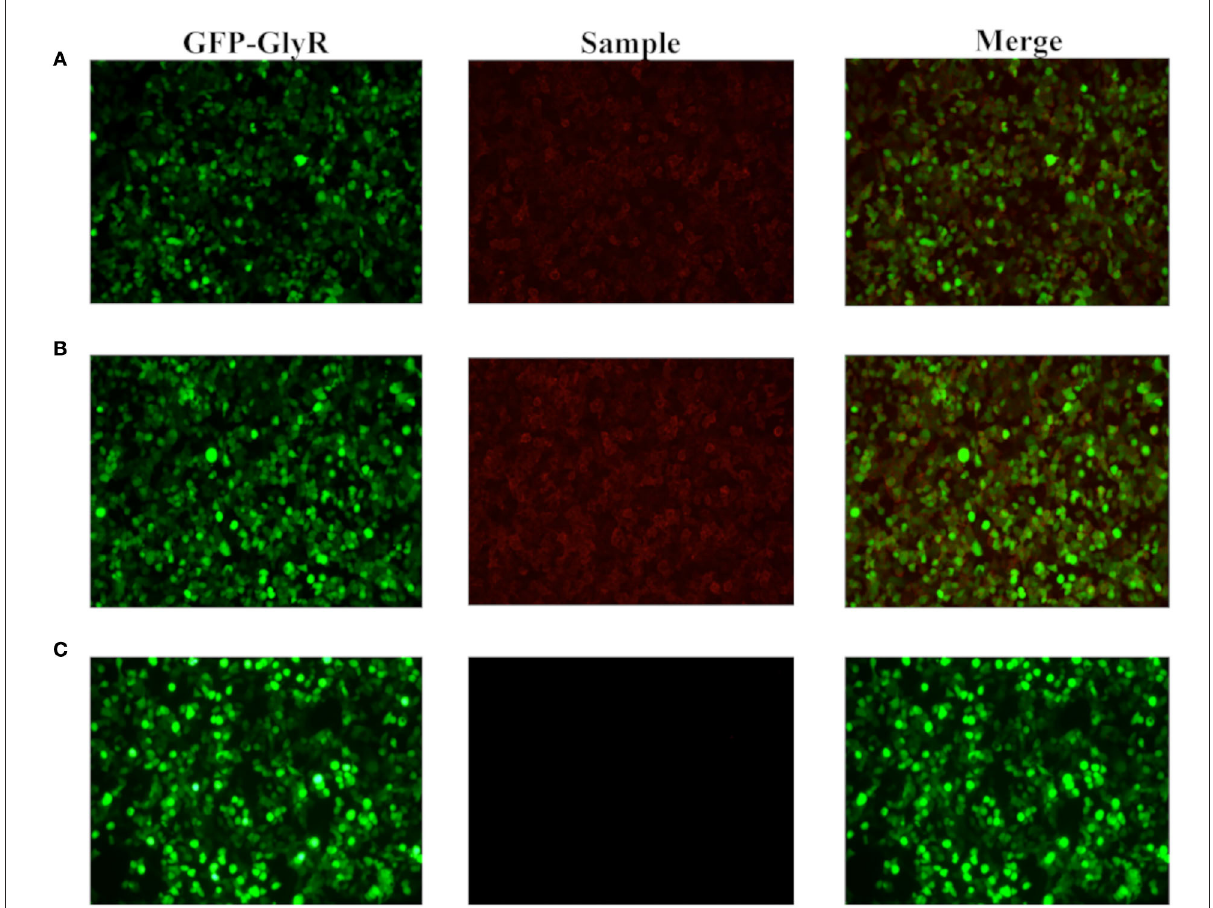
FIGURE3 Blood and cerebrospinal fluid CBA screening. The CBA method was applied to incubate the patient’s cerebrospinal fluid and serum (both diluted 1:100) with human embryonic kidney cell 293T (HEK293T) loaded with GlyR plasmids labeled with green fluorescent protein (GFP). The green fluorescence represents HEK293T cells containing the target antigen, the red fluorescence represents the fluorescent antibody in the specimen, and the positive means that the red fluorescence coincides with a specific part of the green fluorescent cell. Compared with the negative control (C) , there are autoantibodies that bind to GlyR expressed on the surface of HEK293T cells in the patient’s cerebrospinal fluid (A) and serum (B)